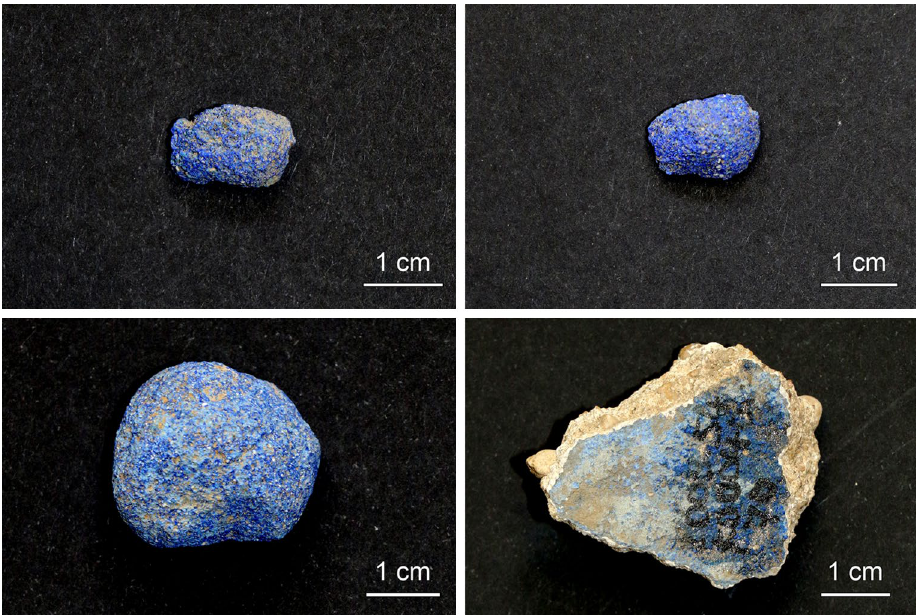
Figure 1. Egyptian blue pigment balls and mural fragment unearthed in the archaeological remains of the ancient Roman cities of Aventicum (top) and Augusta Raurica